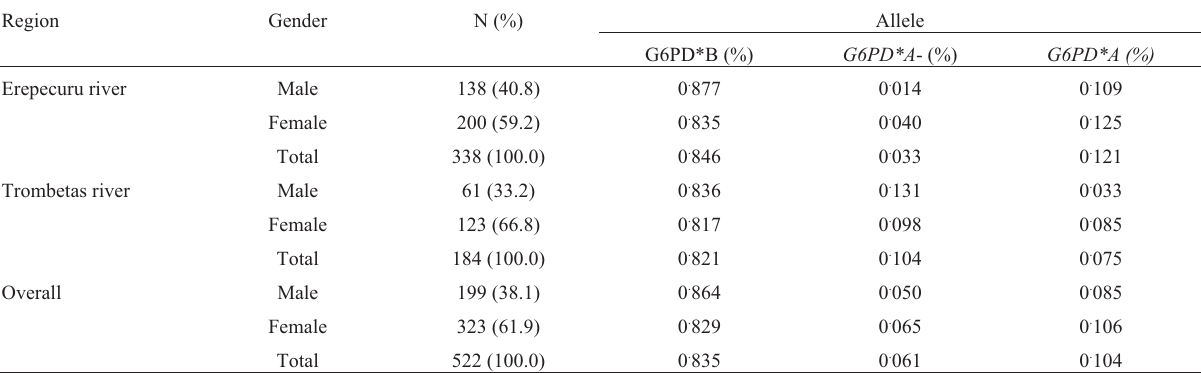
Table 1 - G6PD allele frequencies in Afro-descendant communities from Brazilian Amazon. Region